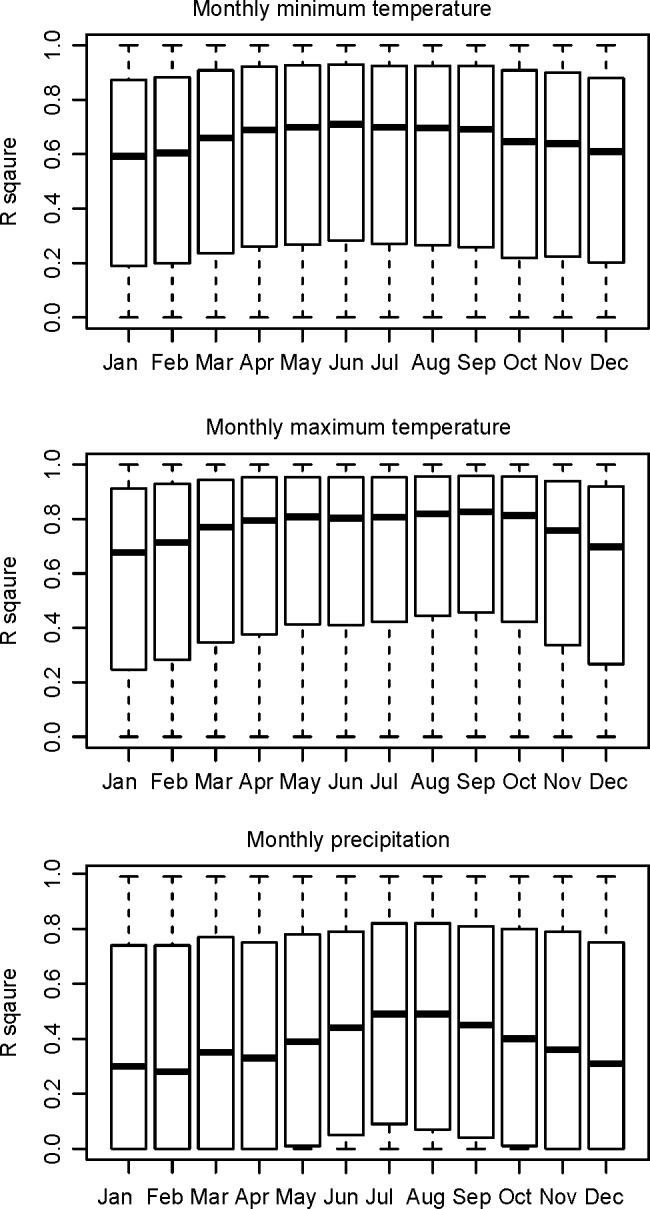
Proportions of variance explained (R square values) by local linear regression in total variation among the nine neighbor pixels for monthly minimum and maximum temperatures, and monthly precipitation across the entire North America.The extent of the box indicates the 25th and 75th percentiles. The horizontal solid lines inside the boxes indicate the medians.